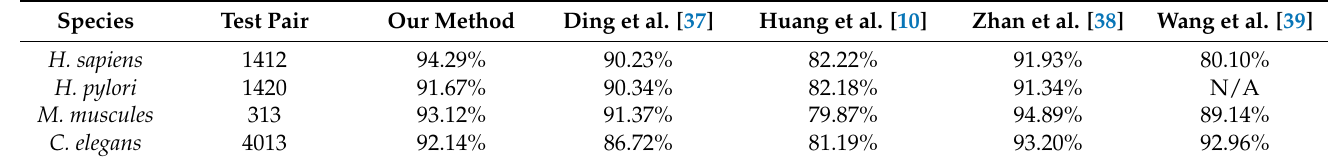
Figure 4. Comparison of the results produced by different classifier models on three benchmark datasets. ( a ) Is the obtained accuracy results on the three benchmark datasets. ( b ) Is the obtained AUC results on the three benchmark datasets. Table 5. Prediction accuracy of the four independent datasets.